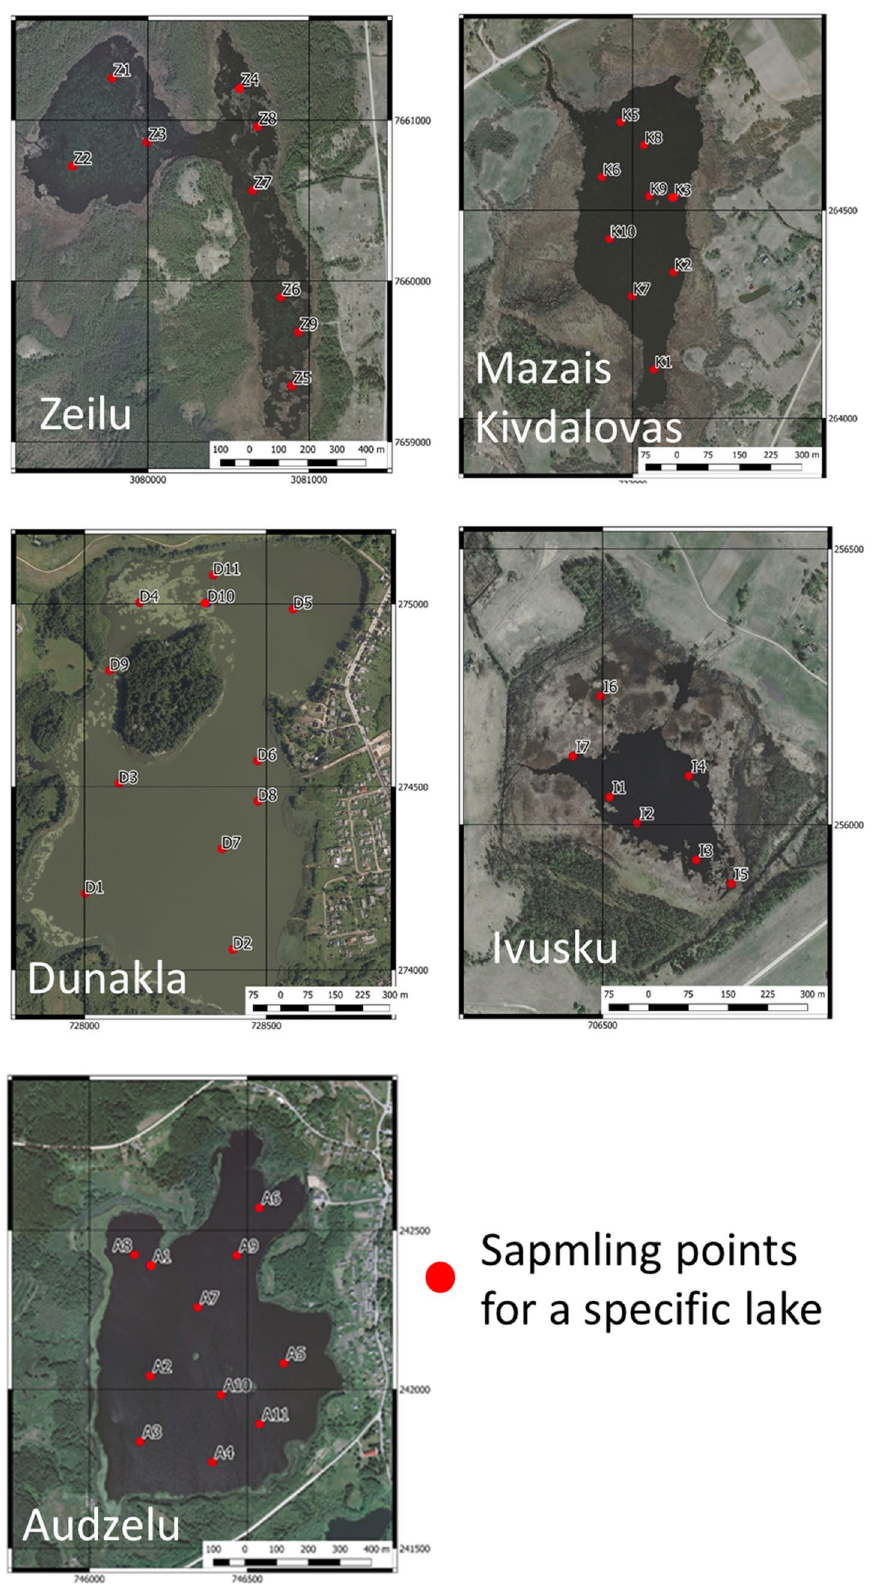
Figure 2. Overview of sapropel sampling points for a specific lake. All pictures were made in cooperation with geological research company “Geo Consultants, Ltd.” and are the property of RSU Laboratory of Hygiene